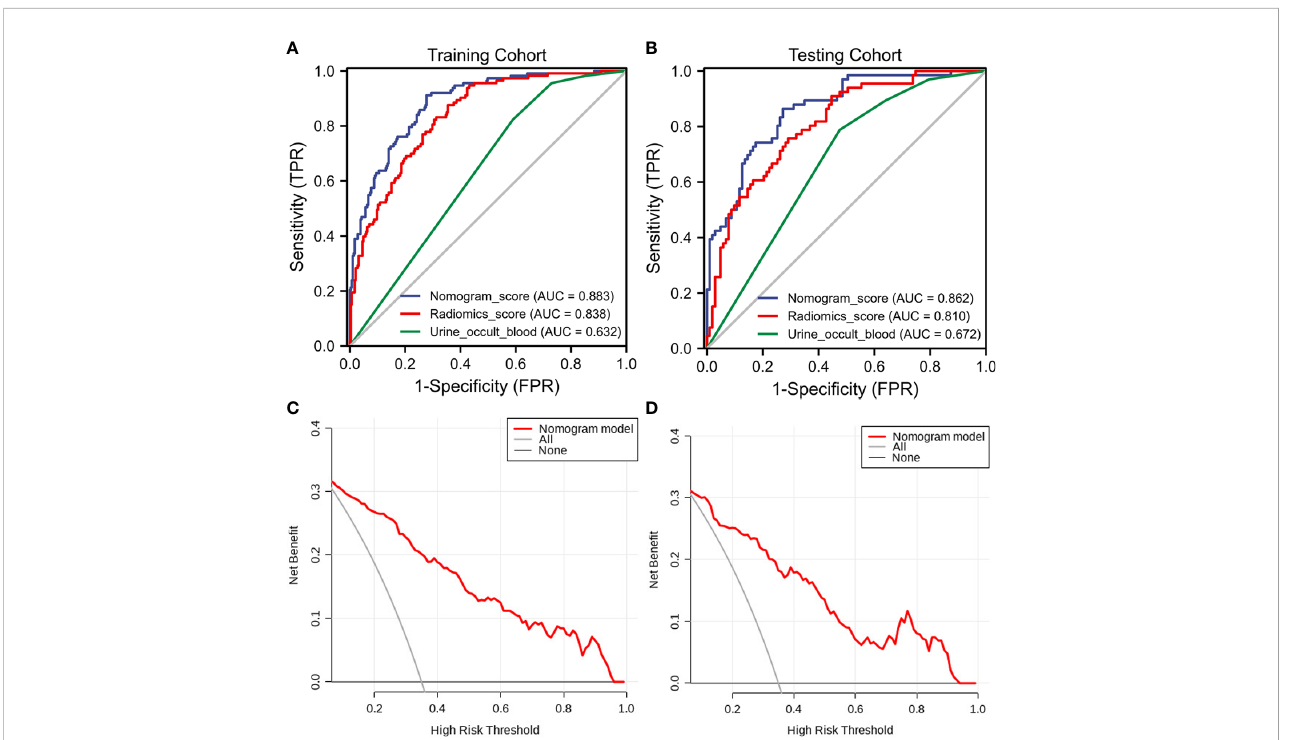
FIGURE 6 The receiver operating characteristic (ROC) curves and decision curve analysis (DCA) of the three models of the three models. (A) Three model ROC curves in the training cohort. (B) Three model ROC curves in the testing cohort. (C) Three DCA models in the training cohort. (D) Three DCA models in the testing